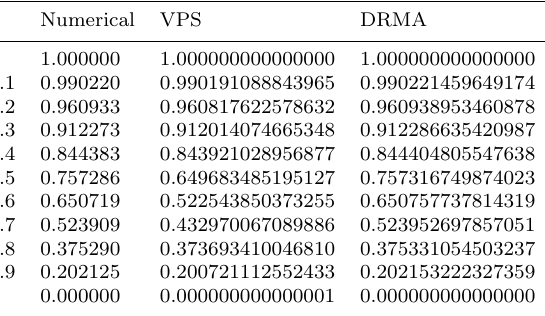
Table 2. Comparison between numerical results [1], the VPS and DRMA solutions for velocity when α = 5 0 , H = 500 , and Re = 25